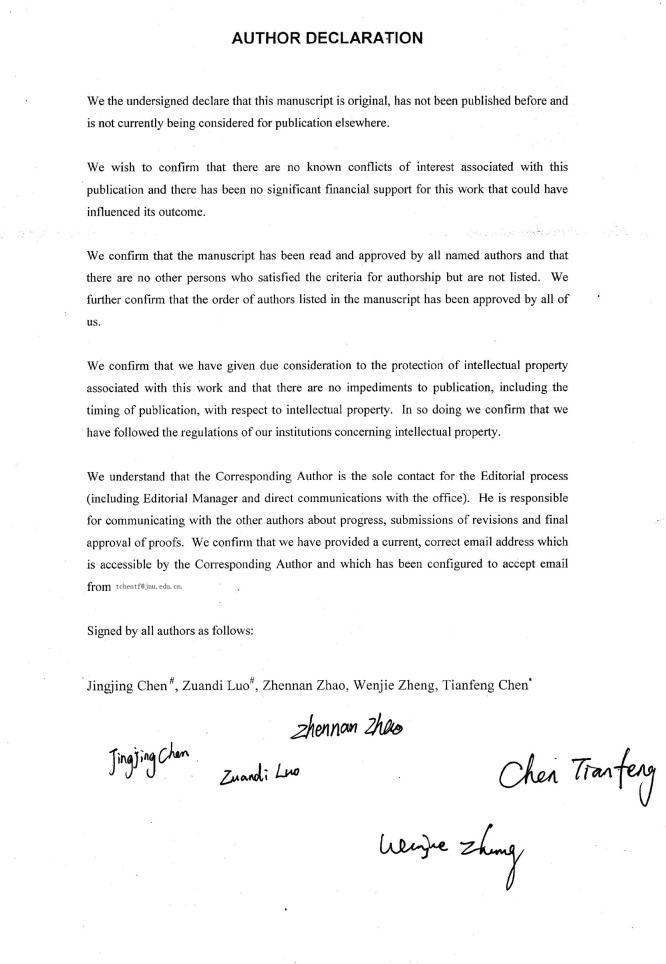
Supplementary material